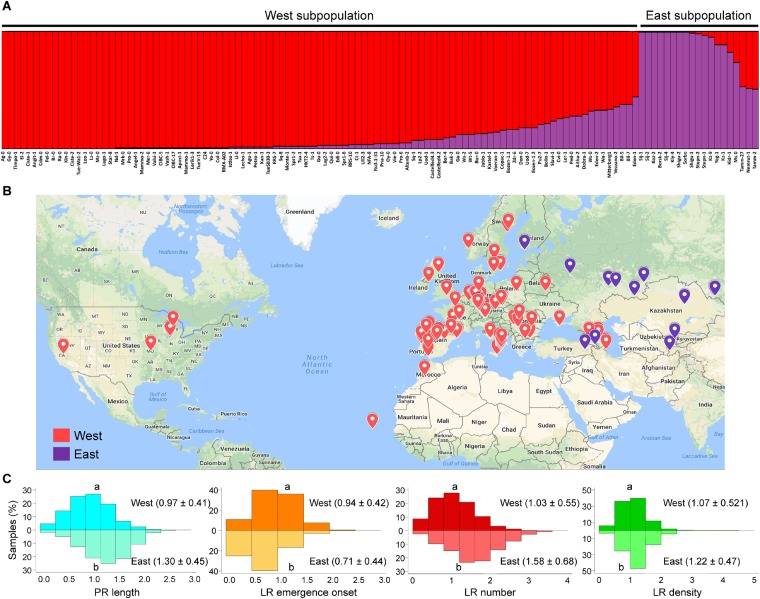
Population structure of the studied accessions. (A) Population structure for the studied accessions using a collection of 319 whole-genome distributed and randomly selected synonymous single nucleotide polymorphism (SNP) markers. (B) Geographical localization of the studied accessions. Accessions from the “West” subpopulation are labeled in red; those from the “East” subpopulation are labeled in purple. (C) Histograms for the studied parameters. Relative data values at 4 dae as compared with the Col-0 reference accession from the “West” subpopulation are represented in the top histograms, while those from the “East” subpopulation are represented in the bottom histograms. Different letters indicate significant differences (LSD, P-value < 0.05).